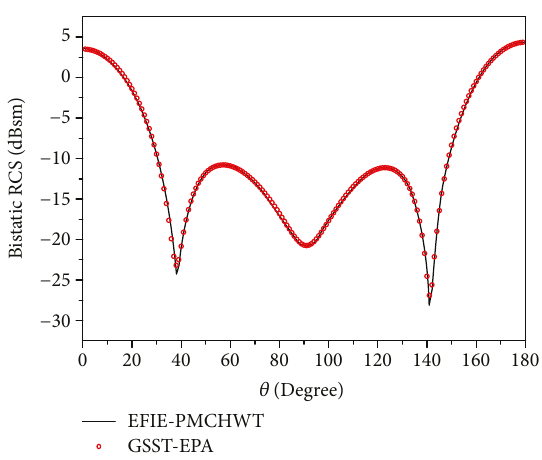
Figure 15: The bistatic RCS of a 3 × 3 bowtie antenna array at 1.0GHz, HH polarization.